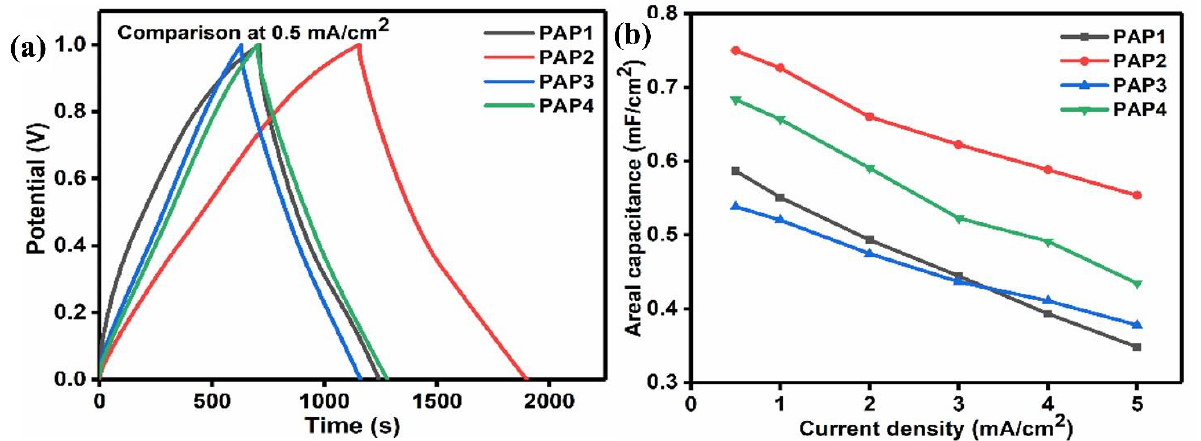
Table 2. The maximum performance properties obtained by the developed samples.